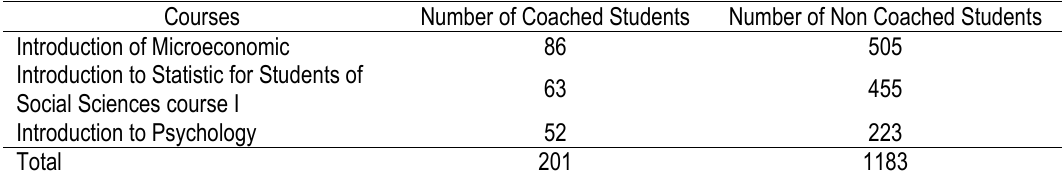
Table 1: Distribution of new students among the three courses